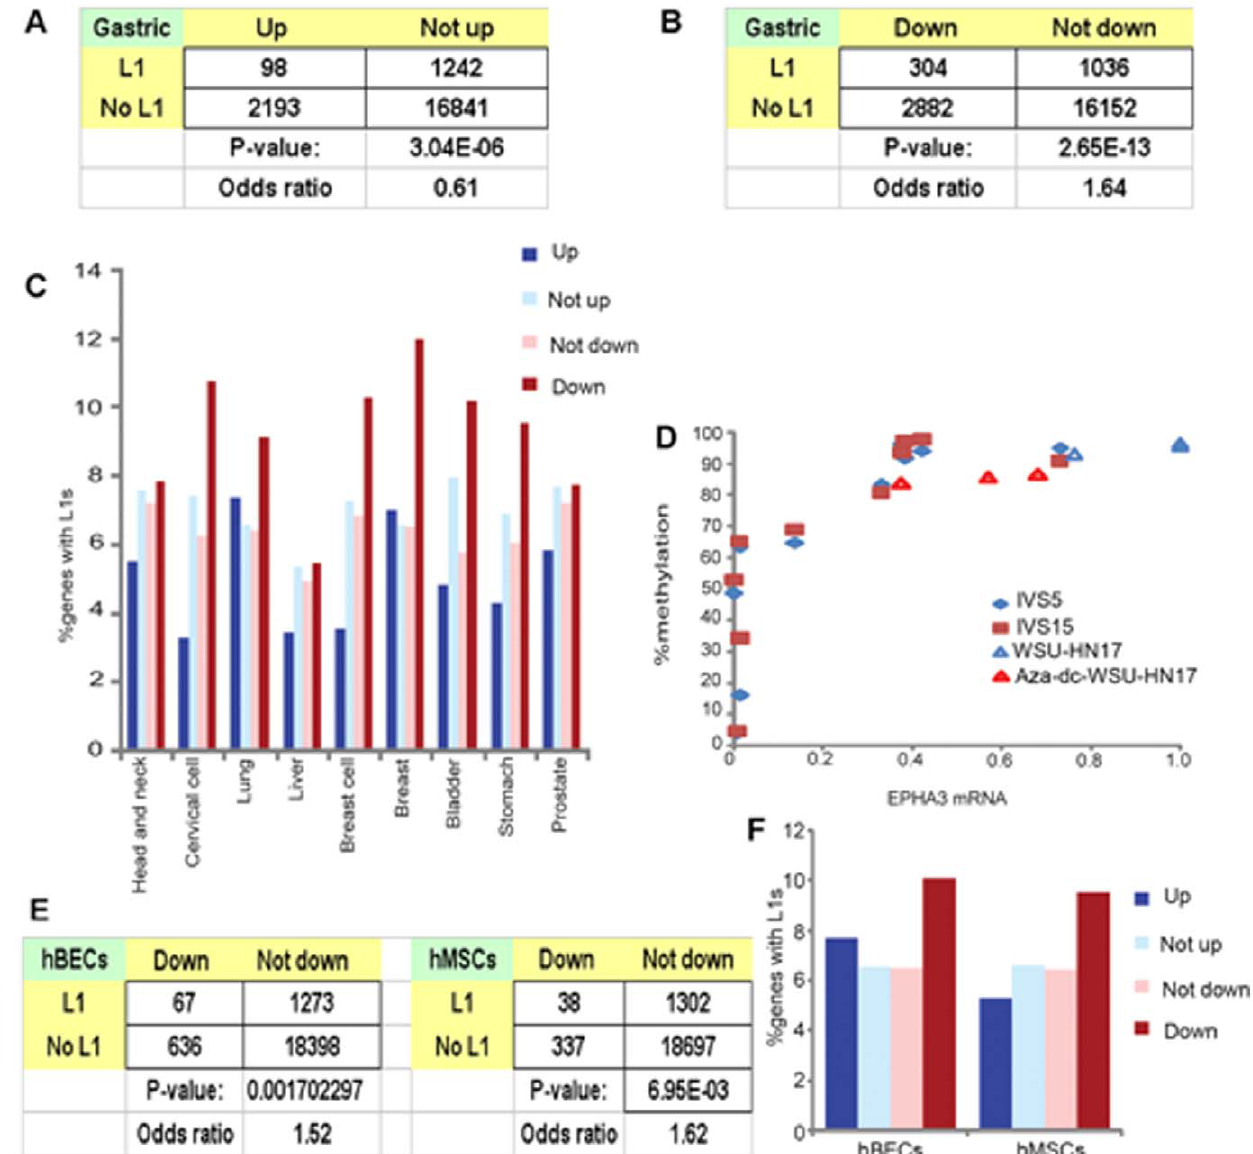
Figure 2. Intragenic L1s repress gene expression in cancer in the same pattern as demethylated normal cells. A) and B) are chi-square 2 6 2 tables, p values and odds ratios, comparing proportions of gastric cancer genes possessing L1s between up- (‘‘Up’’) or down- (‘‘Down’’) regulated and not up- or not down-regulated groups, respectively. C) Percentages of L1-containing mRNAs that are up- or down-regulated in various cancer types. D) EPHA3 mRNA and L1-EPHA3-IVS5 and IVS15 methylation levels in WSU-HN cells and Aza-dC-treated WSU-HN17s. E) Two chi-square 2 6 2 tables, p values and odds ratios, comparing proportions of Aza-dC-treated hBECs or hMSCs genes possessing L1s between down-regulated (‘‘Down’’) and not down-regulated groups, respectively. F) % of mRNAs from genes containing L1s in Aza-dC-treated hBECs and hMSCs. ‘‘Up’’ and ‘‘Down’’ indicate increased and decreased expression, respectively. GSE records, GSM samples and type of t -test and 2 6 2 tables of chi-square tests are provided in Supporting Table